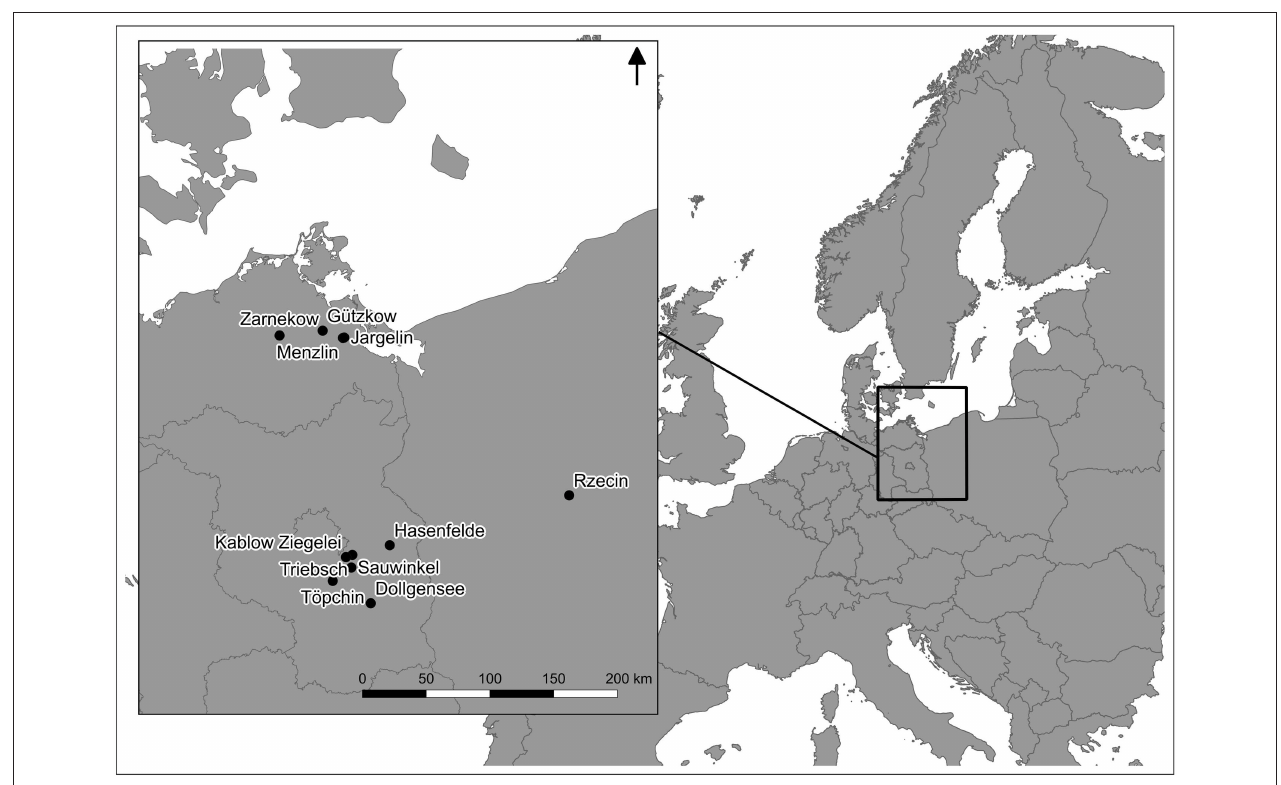
FIGURE 2 | Location of sampled peatlands in NE Germany and NW